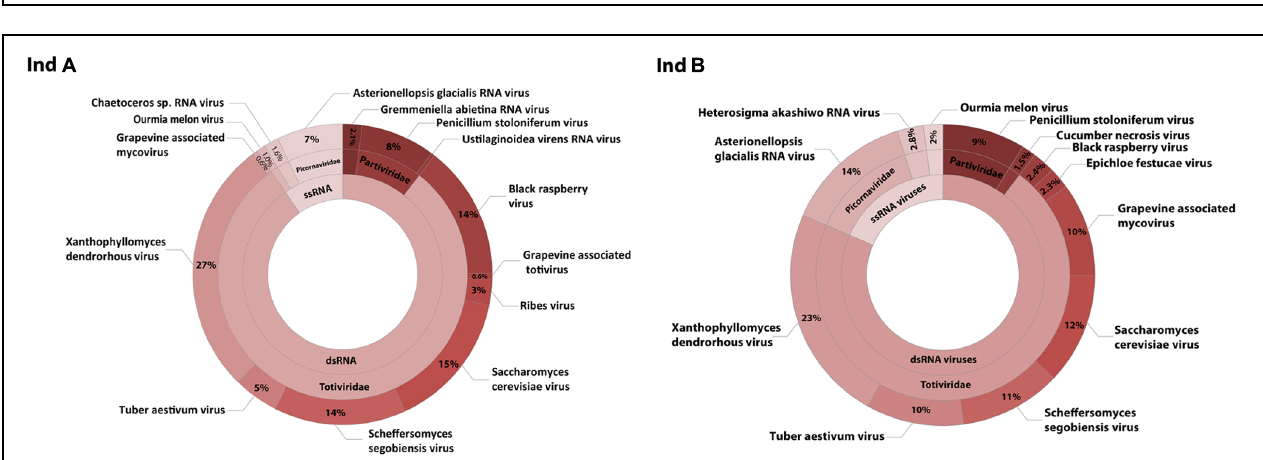
FIGURE 1 | Different morphotypes of virus like particles could be observed in both individuals. Icosahedral viral particles with a diameter of 40 nm (A,D) and another size class with a diameter of 30 nm (E) . Bacilliform to coiled pleomorphic forms (B,C) were detected as well as bacteriophages (F) .